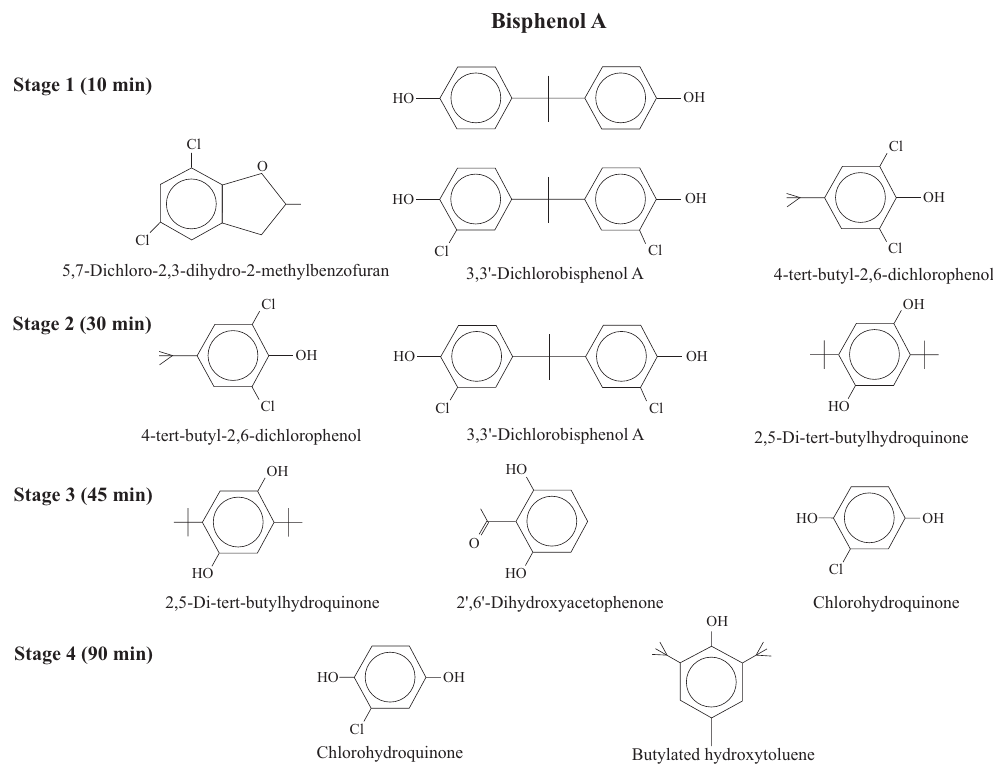
Figure 11. Advanced photocatalytic oxidization of BPA and predicted degradation compounds in GC-MS of the BPA aqueous samples.